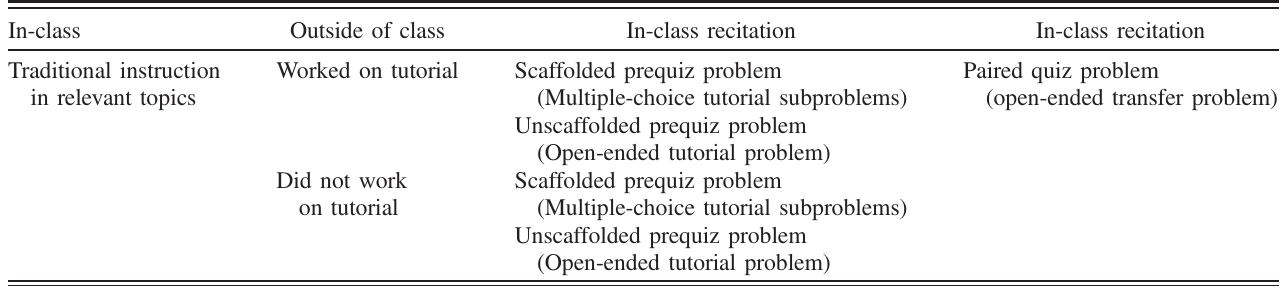
TABLE I. Sequence of activities (from left to right) involving the self-study tools in an algebra-based introductory physics course. In-class Outside of class In-class recitation In-class